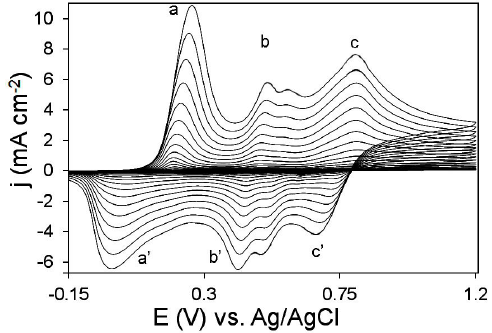
Figure 1: Electro-polymerization of aniline in 0.5 M H 2 SO 4 contain- ing 0.03 M aniline monomer (scan rate: 30 mV s −1 )